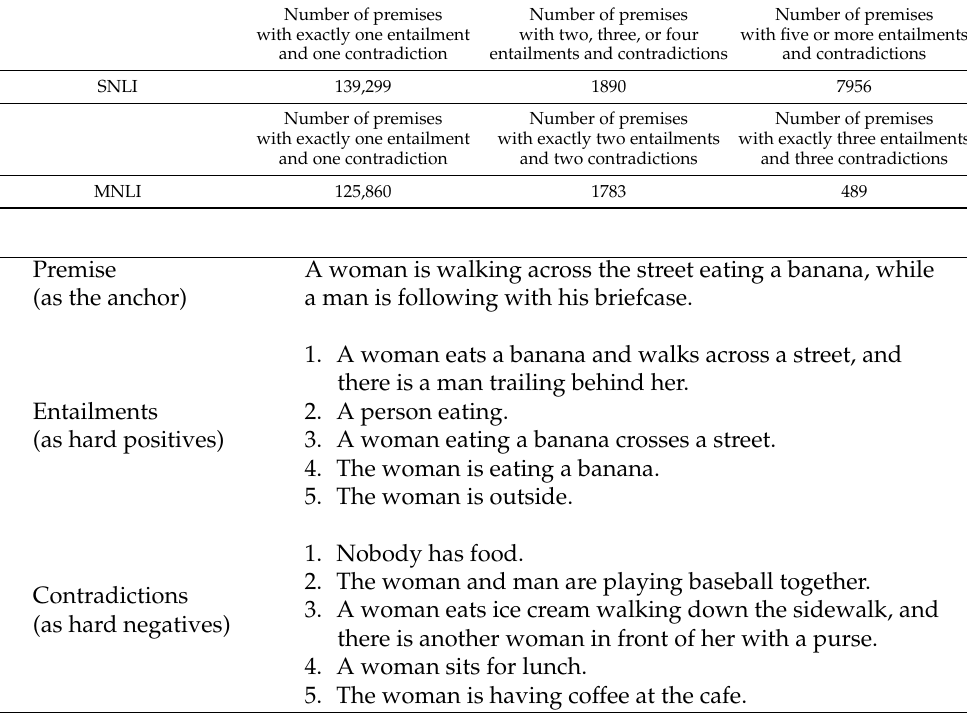
Figure 1. Example of a premise sentence from SNLI [43] with multiple entailment and contradic- tion